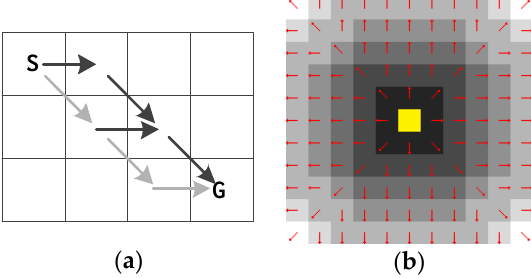
Figure 6. Canonical Ordering in wavefront propagation. ( a ) The possible paths to propagate a wavefront from cell S on left-top to cell G on bottom-right. Among these paths, only the gray one is tested when following the preference rule of Canonical Ordering; ( b ) By following the preference rule of Canonical Ordering, the expansion of a wavefront denoted as red arrows is launched from the center yellow cell and visits each a ff ected cell only